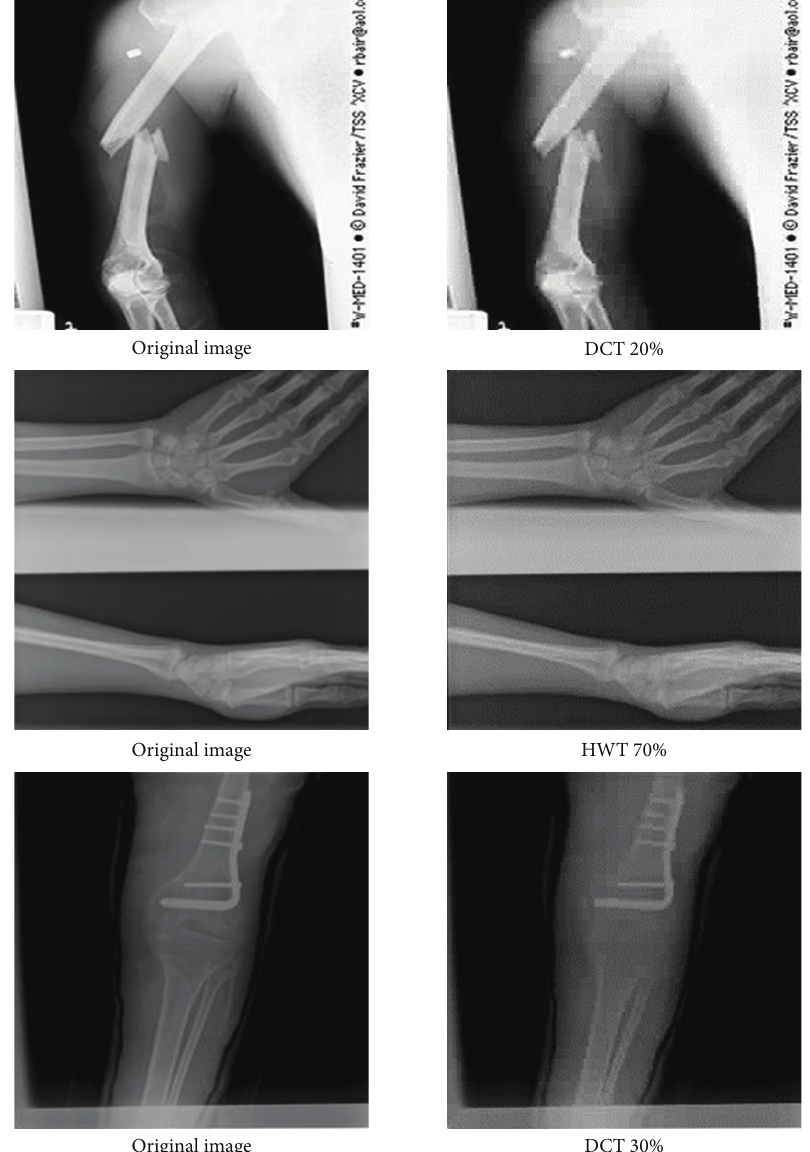
Figure 6: Examples of testing set image compression using the developed